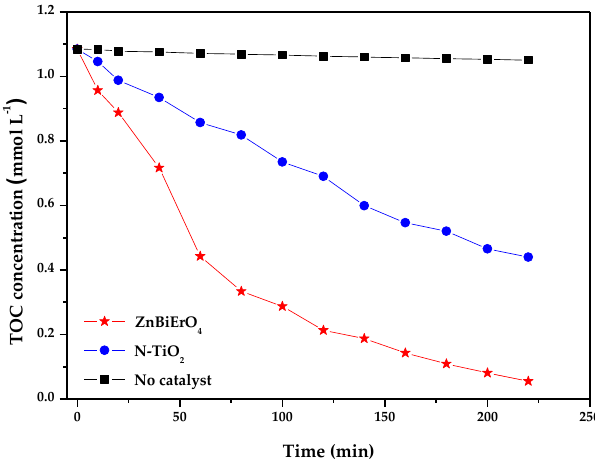
Figure 13. Disappearance of total organic carbon (TOC) during photocatalytic degradation of methyl blue under visible light irradiation in the presence of ZnBiErO 4 and N-TiO 2 as well as in the absence of a photocatalyst.